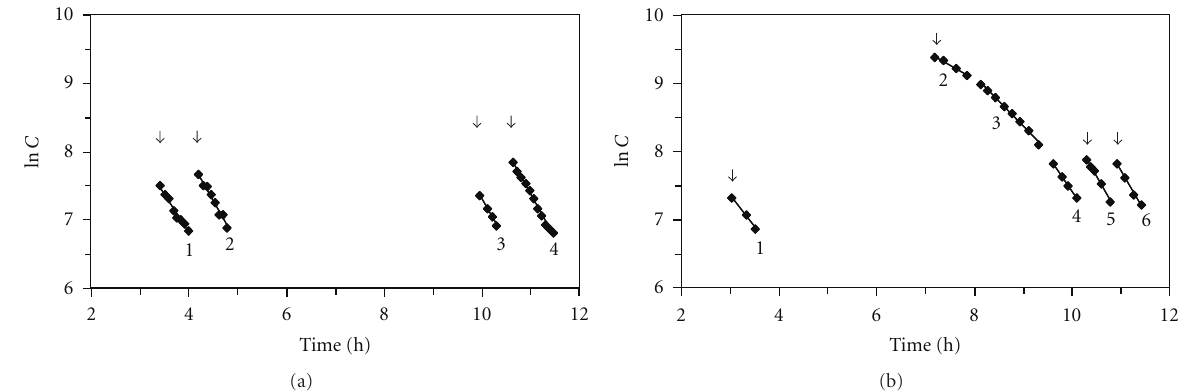
Figure 4: Mytilus edulis . Exponential decrease in algal cell concentration ( C , cells mL − 1 ) as a function of time due to grazing by a group of mussels ( n = 20) in a closed aquarium ( V = 15 . 8L) with well-mixed seawater. Arrows indicate addition of algal cells. Linear regression lines for di ff erent time periods (indicated by numbers) are shown, whereas the slopes ( b ) along with the estimated filtration rates ( F ) are shown in Table 2. (a) Data from Figure 3, experiment no. A2; (b) data from Figure 3, experiment no.